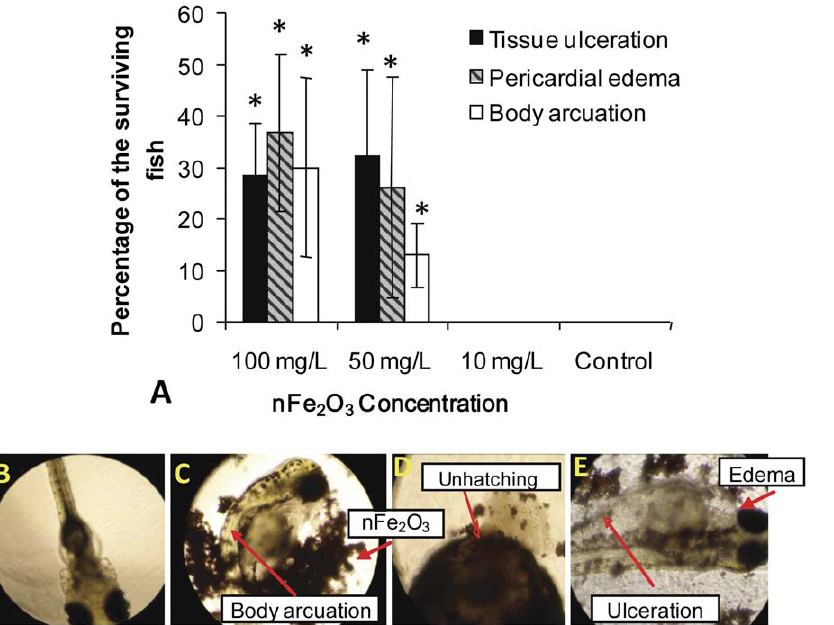
Figure 3. Malformations (e.g., pericardial edema, tissue ulceration, and body arcuation) induced by nFe 2 O 3 at 168 hpf. (A) Malformation percentage in the surviving fish; (B) control fish; (C) hatching fish with body arcuation, treated with 50 mg/L of nFe 2 O 3 aggregates; (D) unhatching embryos, treated with 50 mg/L of nFe 2 O 3 aggregates, dead at 168 hpf; (E) hatching fish with pericardial edema, treated with 100 mg/L of nFe 2 O 3 aggregates. Error bars represent 6 one standard deviation from the mean of three replicates. Significance indicated by: * p , 0.05.